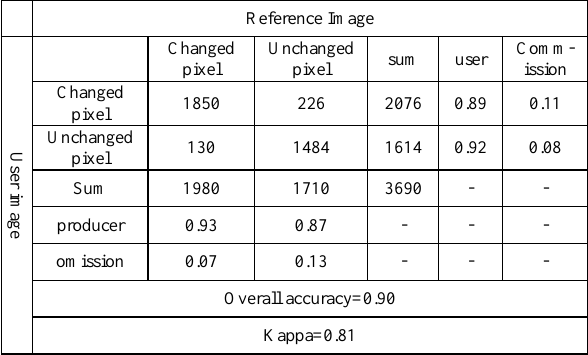
Figure 10. Change detection result of object-oriented method with dNDVI